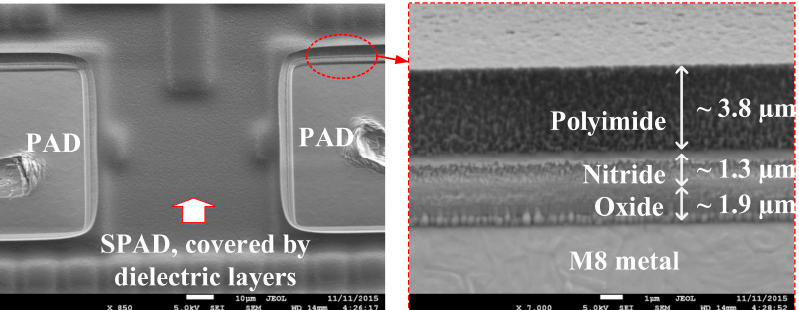
Figure 12. Scanning electron microscope image of SPAD: Top view ( left ) Cross-sectional view of top layers ( right ) [120].